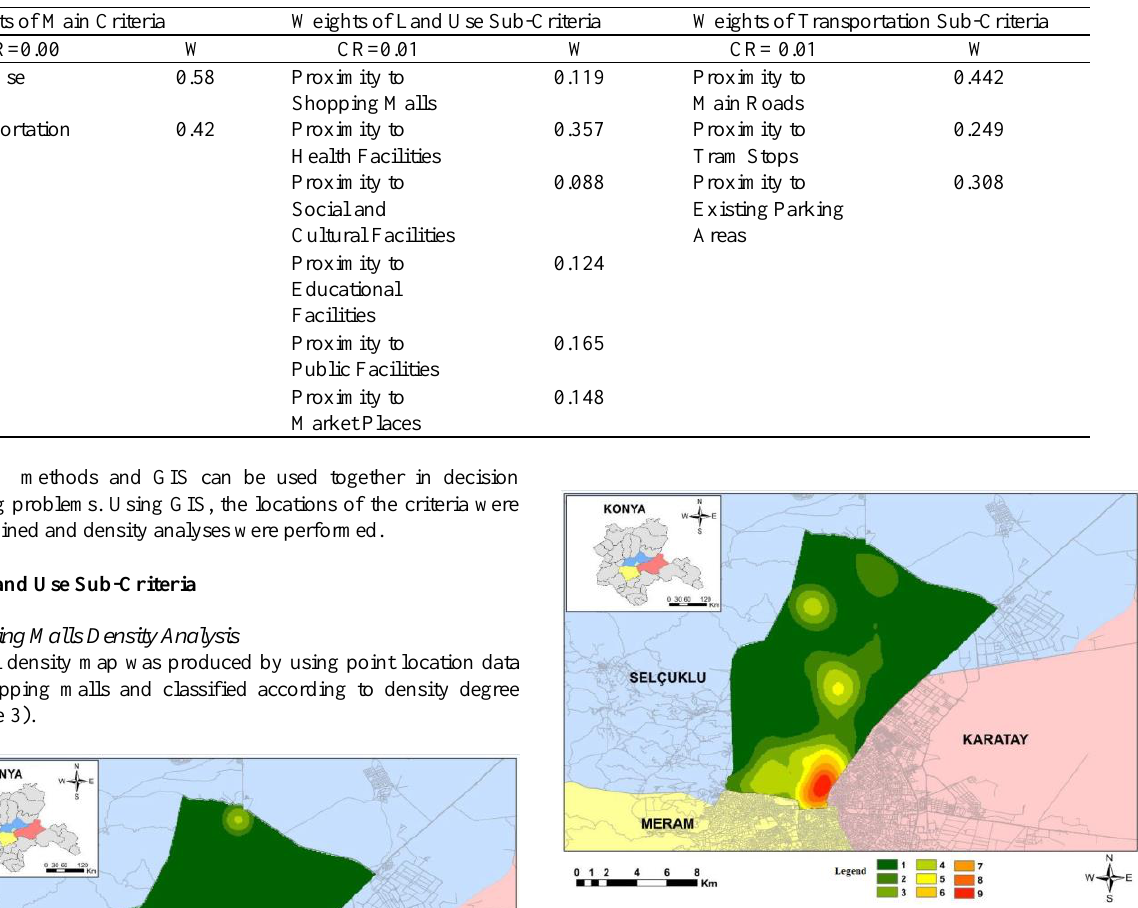
Figure 4. Health facilities density